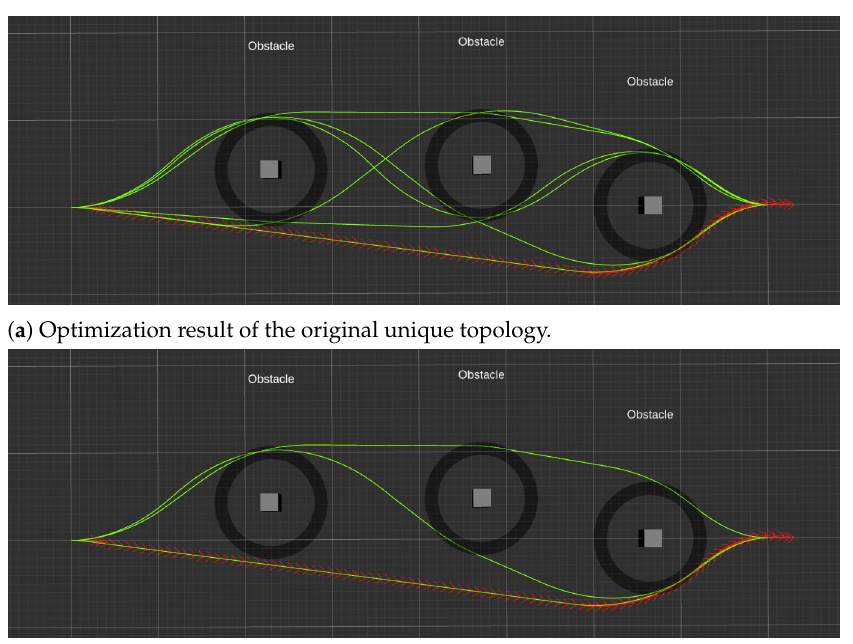
Figure 11. The results of trajectory optimization. In both ( a , b ), three small gray cube obstacles are placed in Rviz. The black circle around the obstacle indicates the minimum safe distance between AGV and the obstacle. The red line is the optimal trajectory, including the position and attitude of each point.